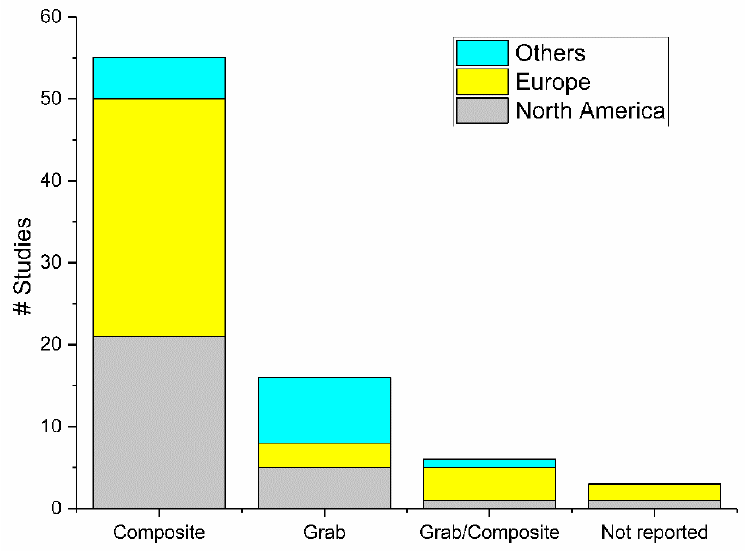
Figure 3. Number of studies based on sample collection type in different continents (others = coun- tries from Asia, Africa, Australia, and South